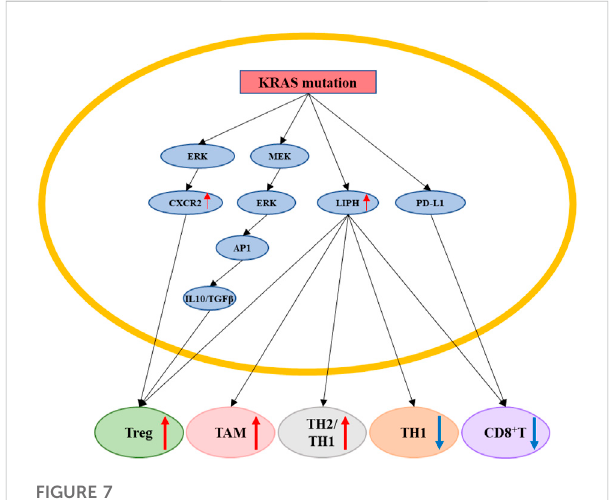
FIGURE 7 KRAS mutation promotes pancreatic cancer cells immune escape. KRAS mutation can indirectly affect pancreatic cancer cells by regulating the tumor immune microenvironment by regulating ERK/ CXCR2, MEK/ERK/AP1/(IL10&TGF β ), LIPH, PD-L1. KRAS mutation could upregulate the proportion of Treg, TAM, TH2/TH1 cells, and downregulate the proportion of TH1, CD8+T cells. Red arrow: The expression of related gene is upregulated. Blue arrow: The expression of related gene is